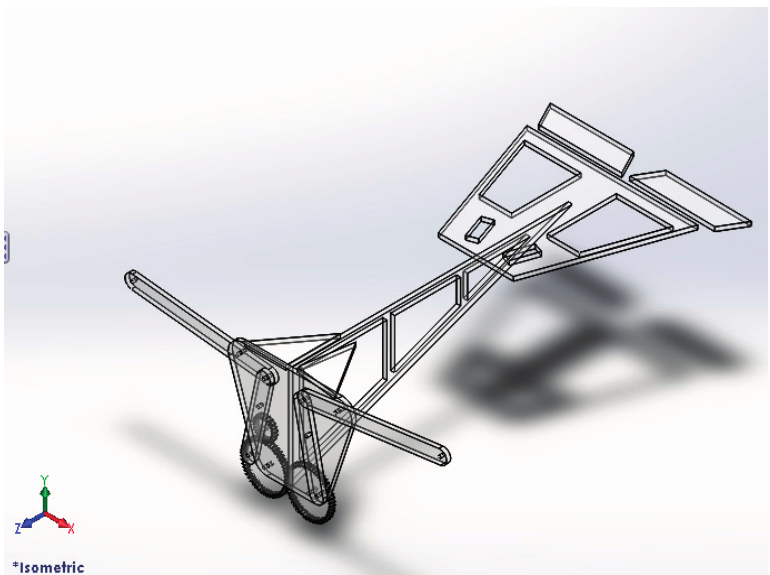
Figure 54. Articulated flapping wing.